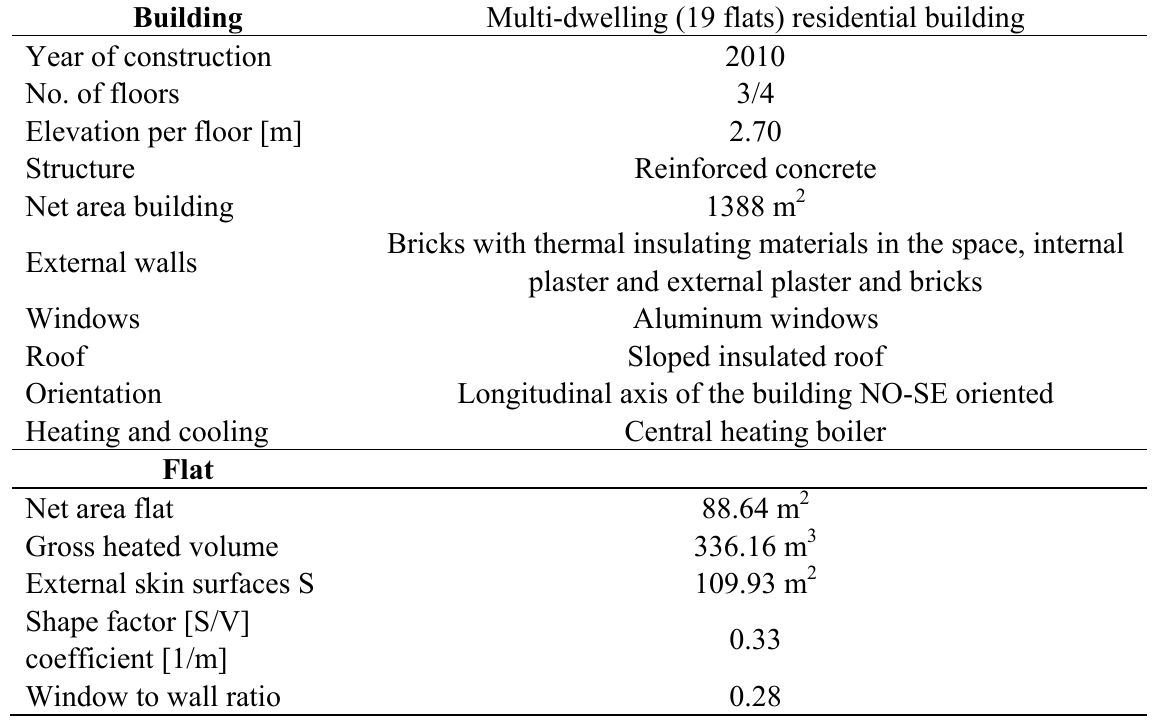
Table 3. Main features of the building and of the flat considered as case-study.